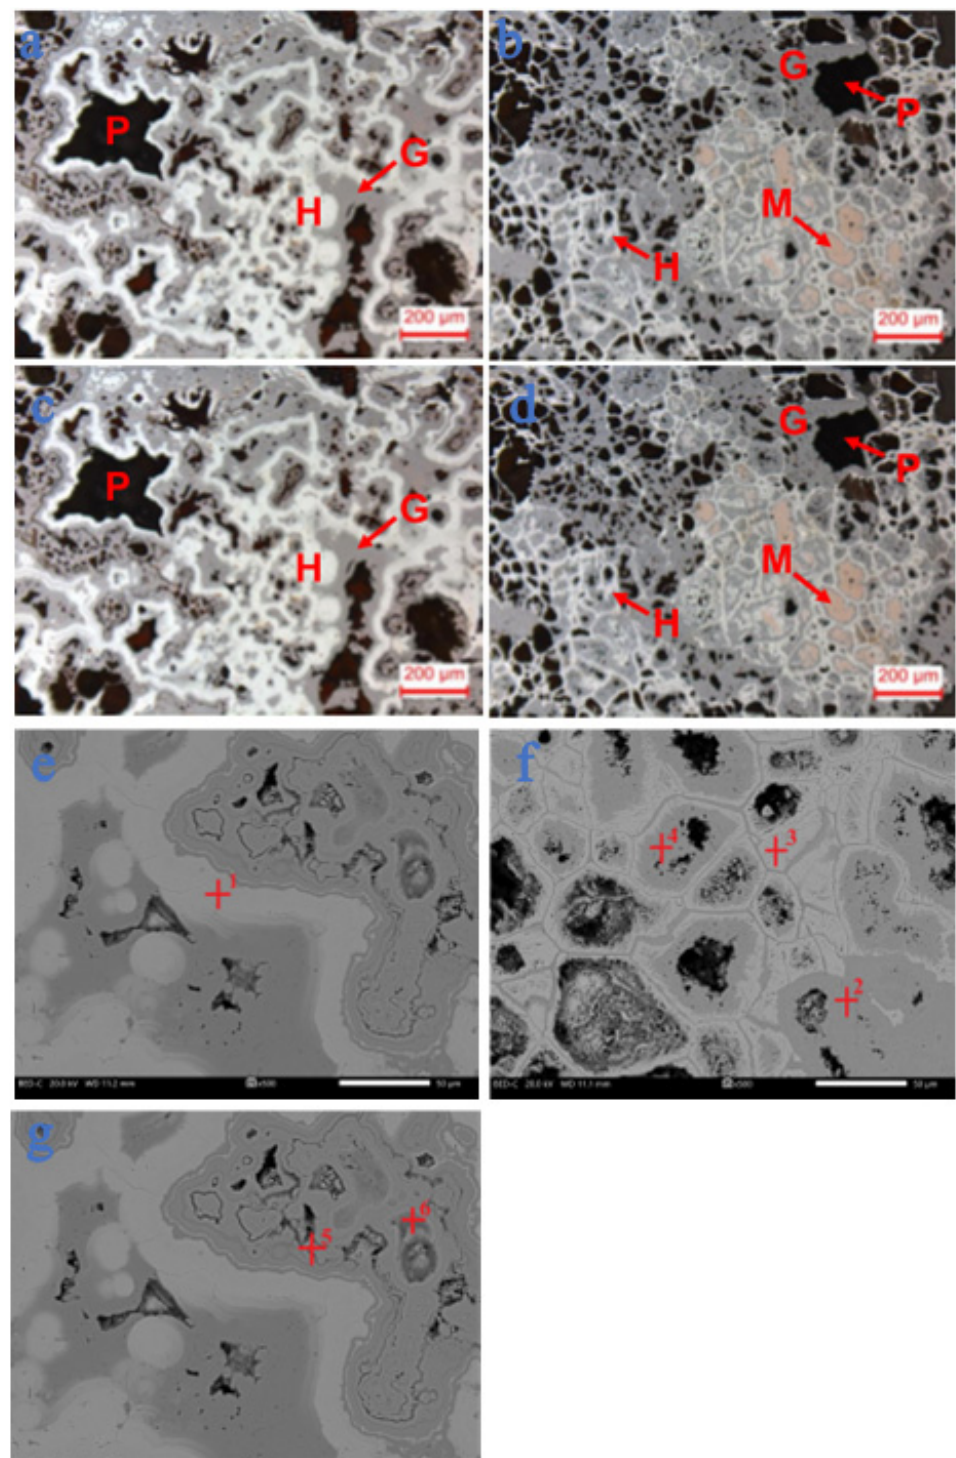
Figure 4. Microstructure and main physical phases of lump S. ( a ‐ g ) Table 6. EDS analysis results for areas in Figure 4.